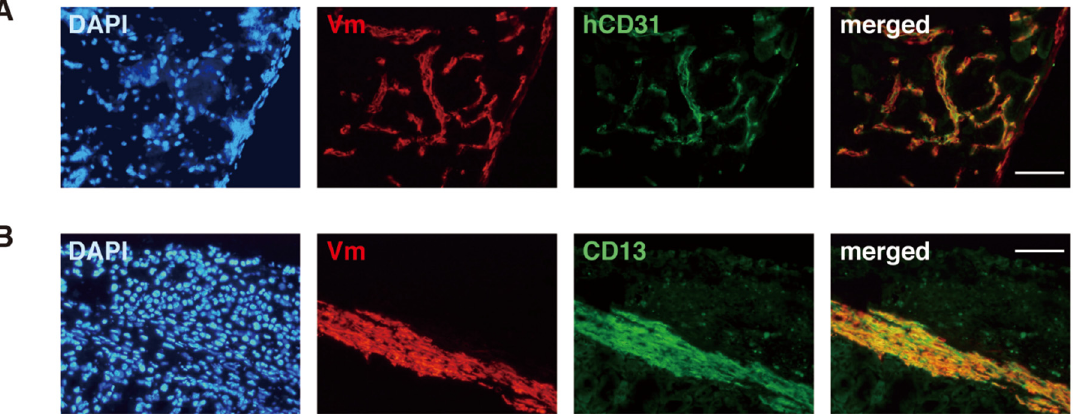
Figure 3. Expression of endothelial and stromal cell markers (hCD31 and CD13, respectively) in human-derived cells pre- sent around an ESP-initiated lesion. Immunofluorescence images of the ESP-initiated lesion in immunodeficient mouse kidney co-stained with DAPI and antibodies against only human vimentin (Vm) and hCD31 ( A ) or antibodies against Vm and CD13 ( B ). Bars, 100 µm. Reproduced from [36] under a CC BY license, with permission from PLOS ONE, original copyright